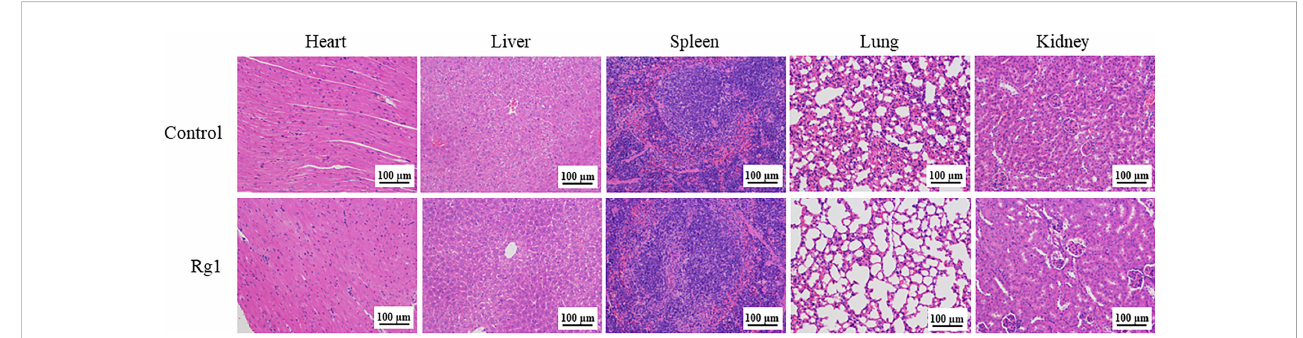
FIGURE 9 Healthy nude mice were intraperitoneally (i.p.) injected with phosphate-buffered saline (PBS; 100 µL, Control group) and ginsenoside Rg1 (50 mg/kg, 100 µL, Rg1 group), respectively. After 24 h, the heart, liver, spleen, lung, and kidney were stained with hematoxylin and eosin (H&E) staining